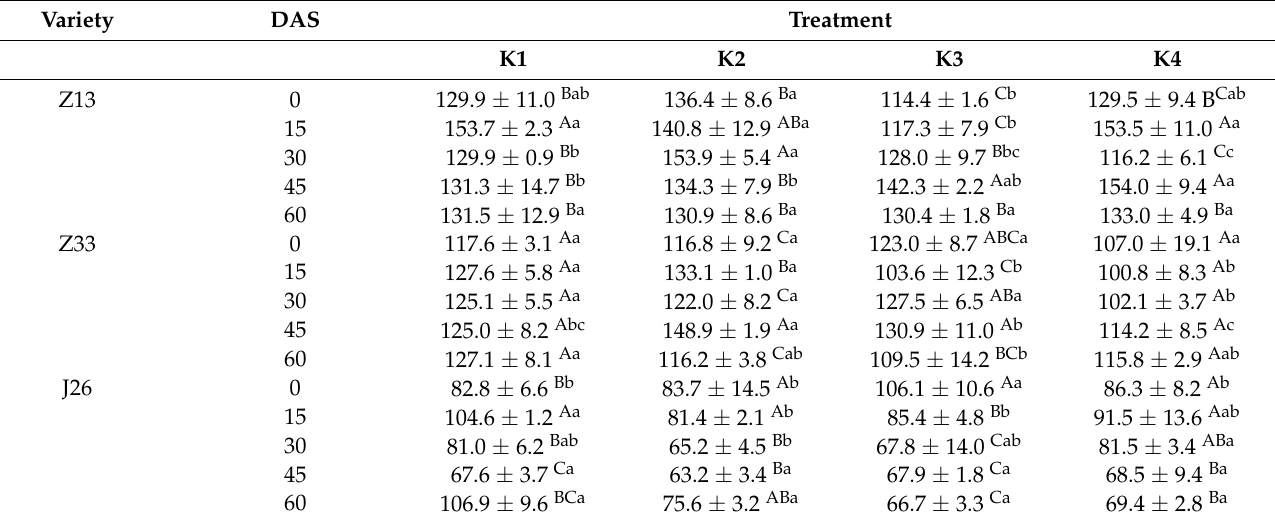
Table 4. Chewiness of the slice of tuberous root